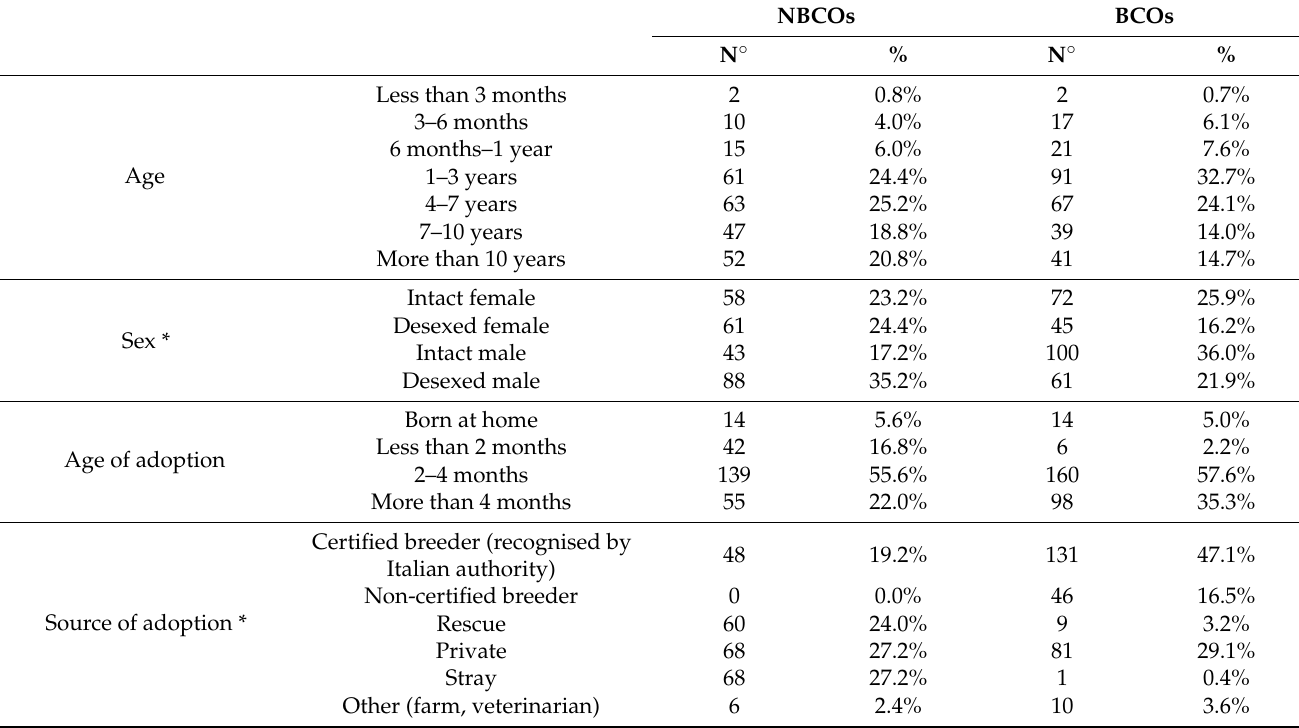
Table 2. Representation of cat demographics by